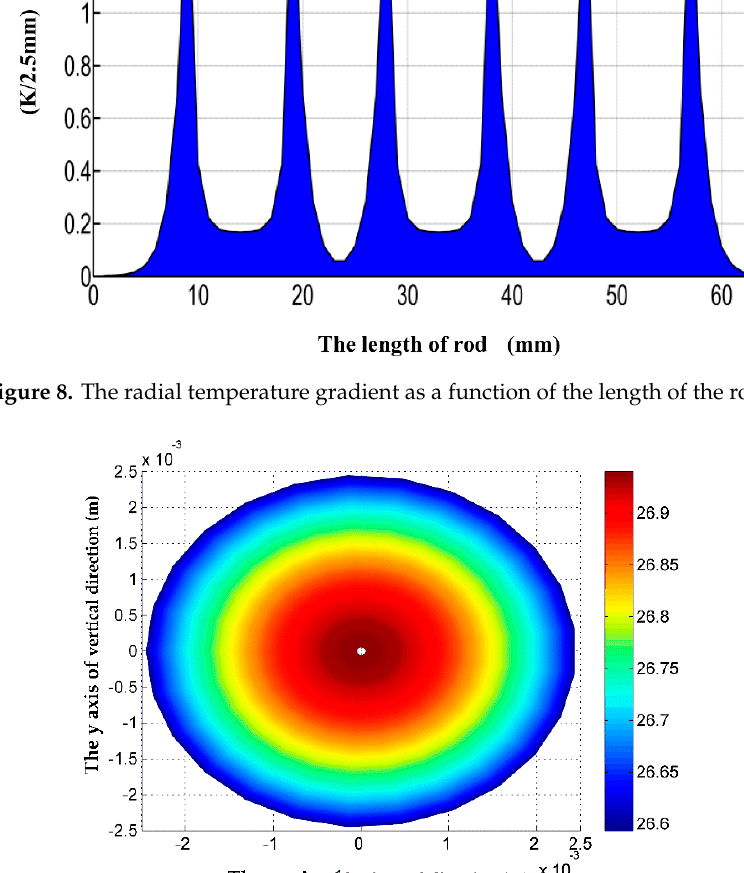
Figure 8. The radial temperature gradient as a function of the length of the rod.